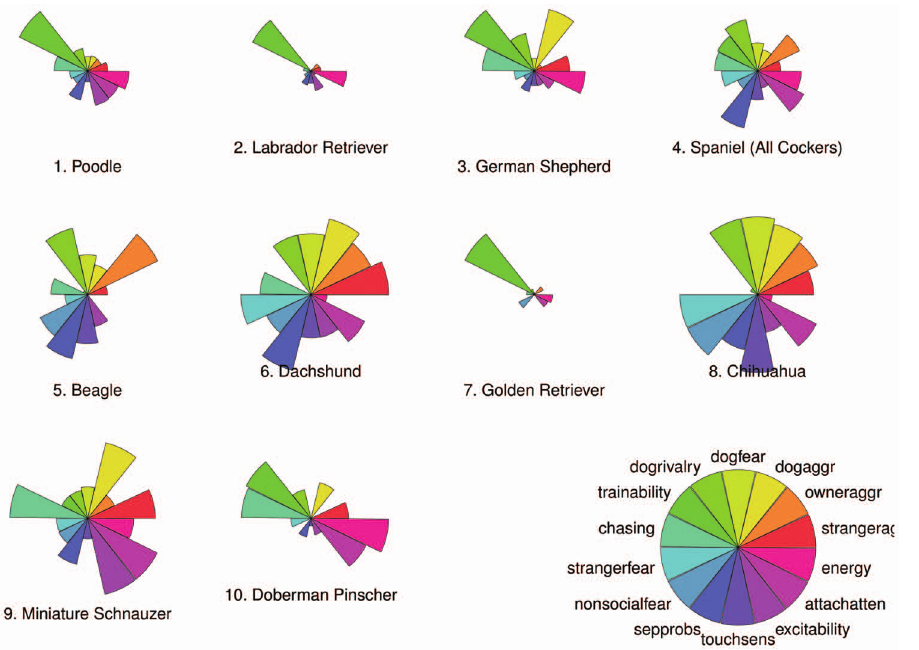
Figure 1. Behavior and temperament measures for the 10 most popular dog breeds. Behavior and temperament measures for the 10 most popular dog breeds in the AKC database, years 1926–2005. Measures are defined in Table